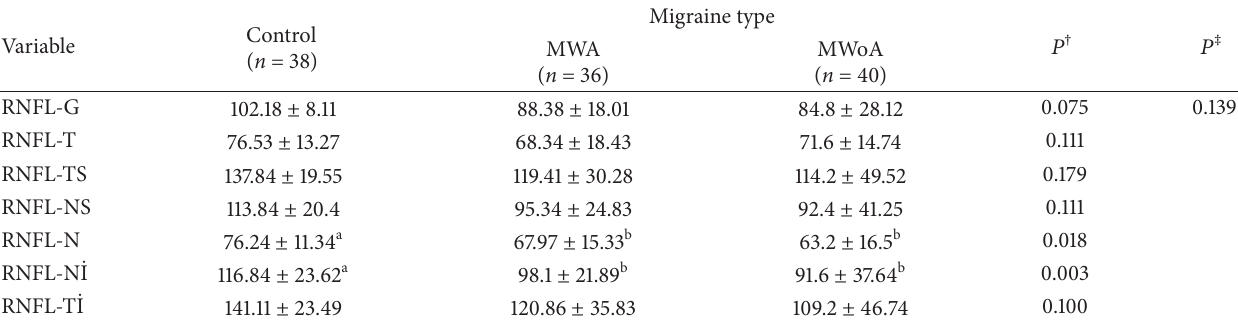
Table 2: Comparison of the peripapillary retinal nerve fiber layer (RNFL) thickness ( 𝜇 m) of the migraine types and control